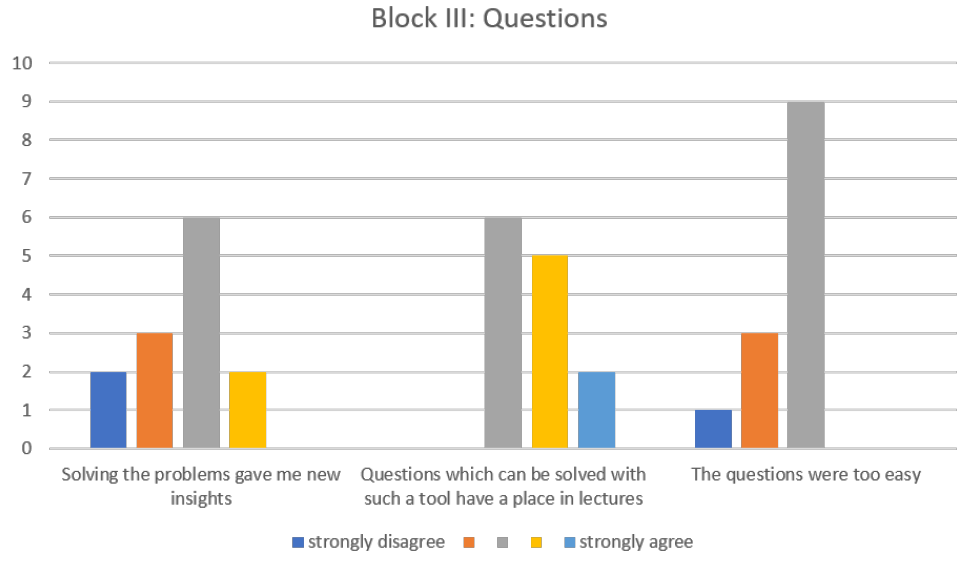
Figure 21. Third set of questions regarding the applicability